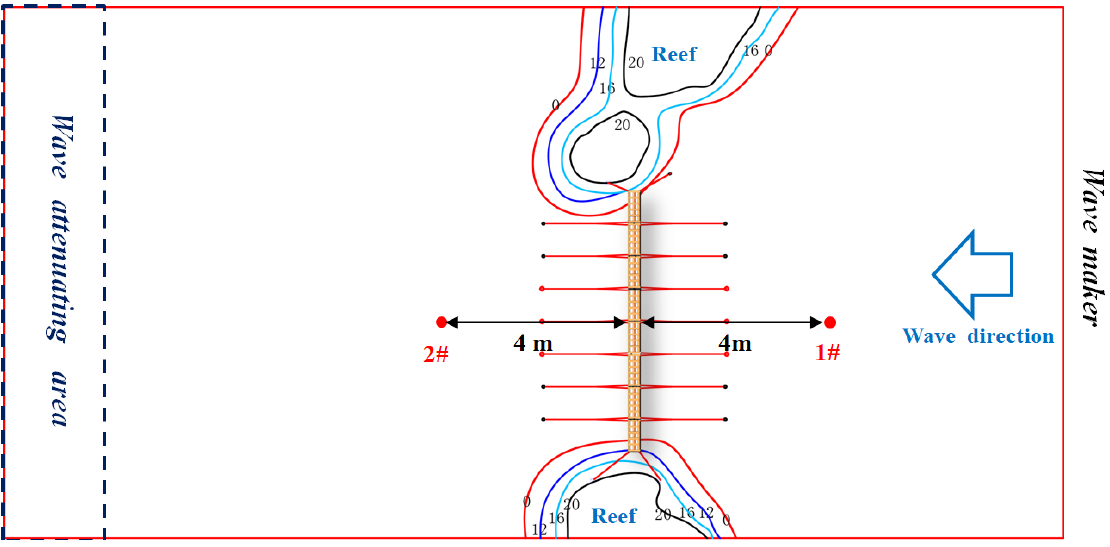
Figure 6. Schematic diagram of wave gauges measuring point layout.